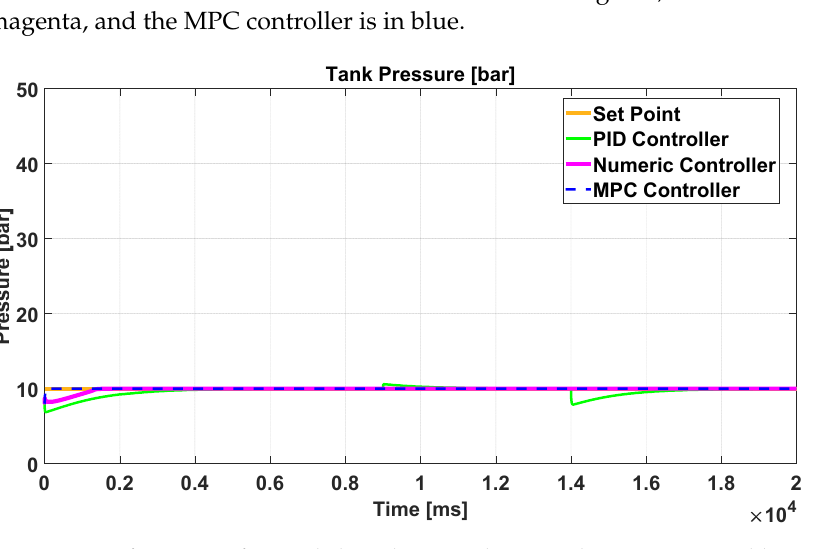
Table 2. Comparison of PID, numerical, and MPC performance in terms of the pressure variable. Parameters PID Numerical MPC Overshoot (%) 0 0 Settling time (s) 252.9 Steady-state error (bar) 0 0 0